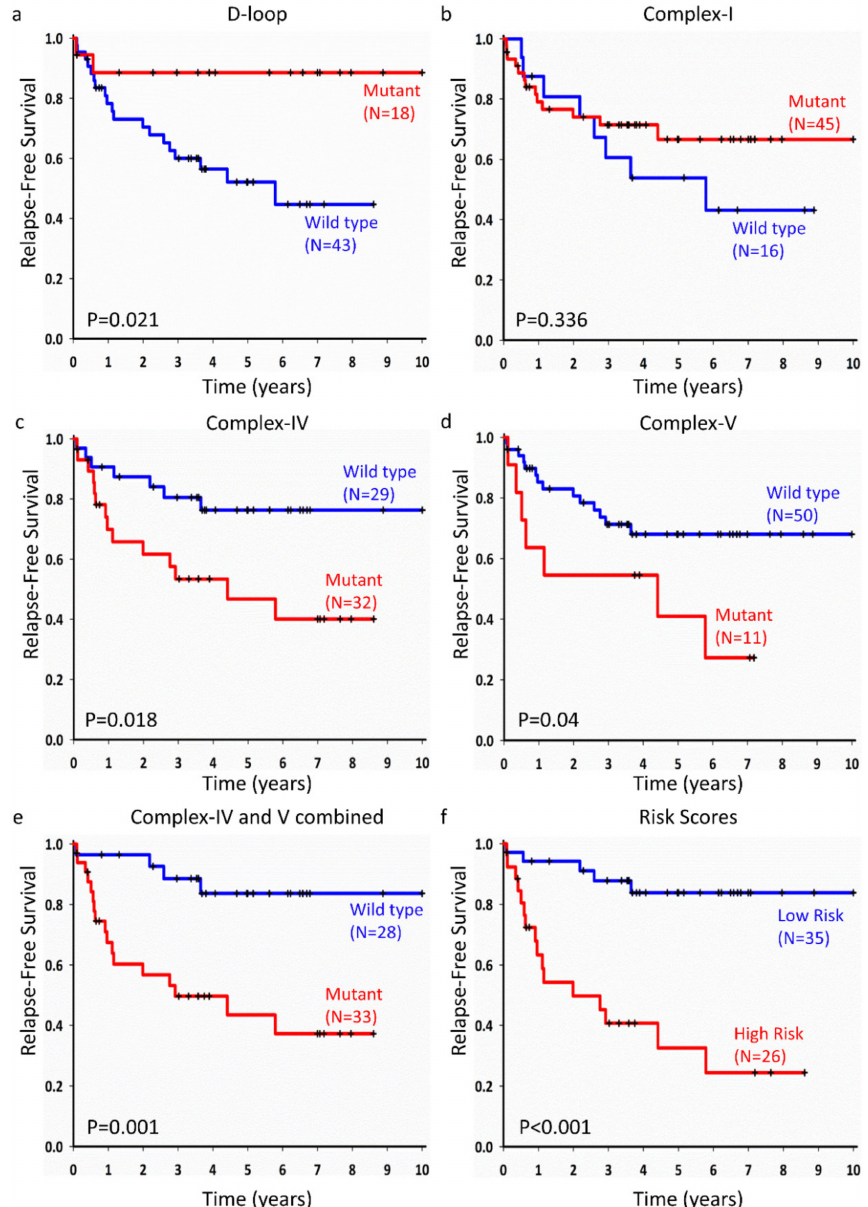
Figure 5. Kaplan–Meier estimation of relapse-free survival of early-stage lung adenocarcinoma patients. Mutations in the D-loop region ( a ) were associated with longer relapse-free survival, whereas mutations in Complex IV genes ( c ), Complex V genes ( d ), and Complex IV and Complex V combined ( e ) were associated with shorter relapse-free survival. No significant association was observed for Complex I mutations ( b ). For the risk-score-based stratification, patients with low risk scores showed better relapse-free survival ( f ). p -values were computed using the two-sided log-rank